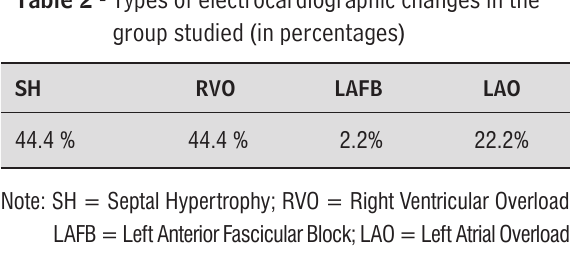
Note: SH = Septal Hypertrophy; RVO = Right Ventricular Overload; LAFB = Left Anterior Fascicular Block; LAO = Left Atrial Overload. Source: Research data.